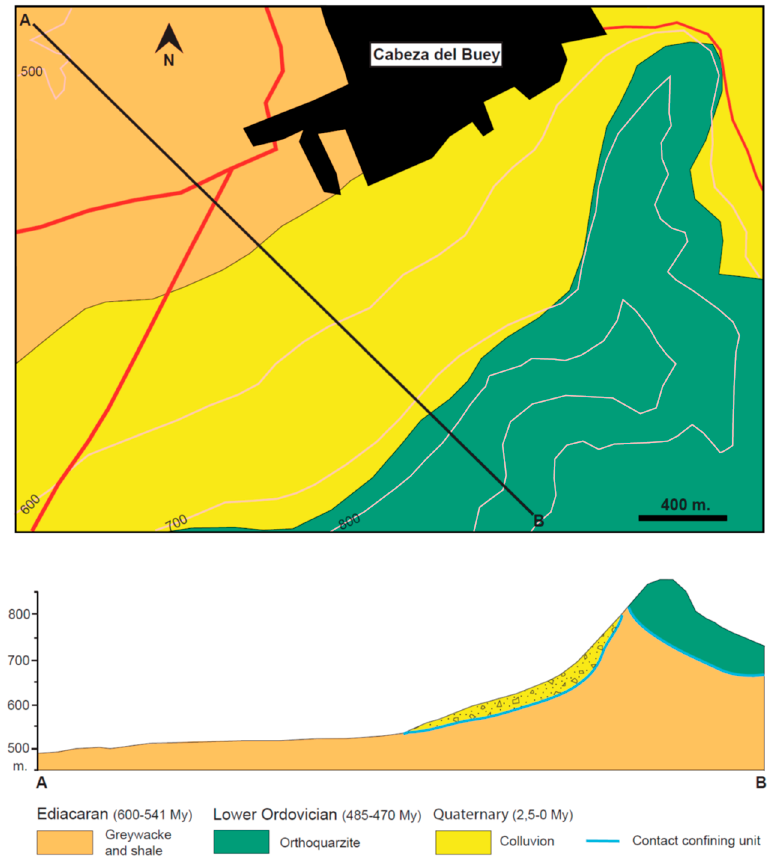
Figure 2. Geological map of Cabeza del Buey and Pedregoso Mountains and geological cross-section of the north slope of the Mountain Range.